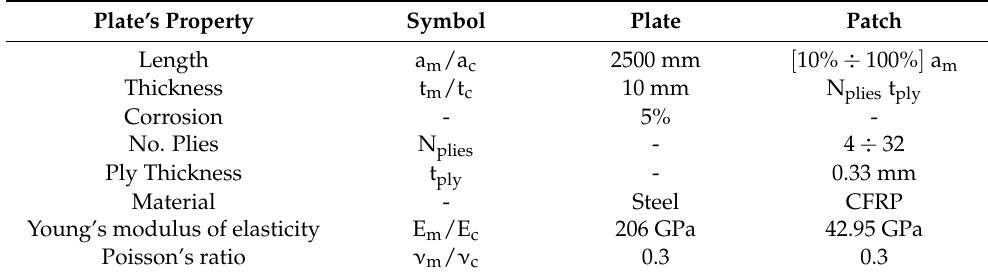
Table 1. Plate’s and patch’s modeling particulars.